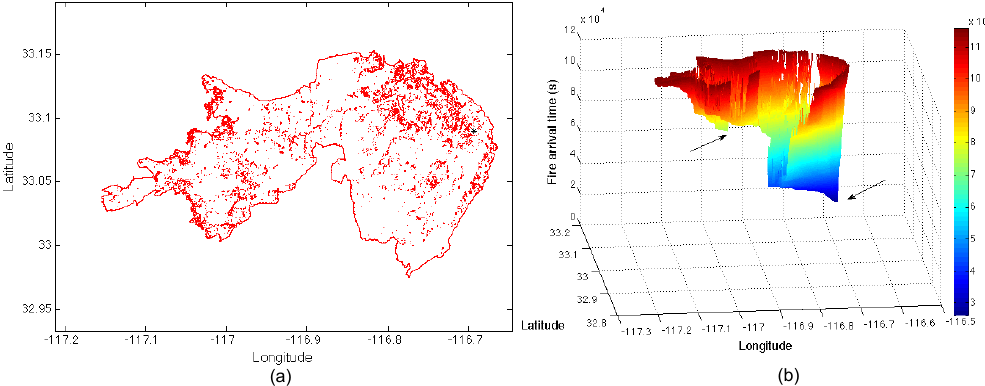
Figure 4. (a) Perimeter of the 2007 Santa Ana fires simulation 22 October 2007, 13:00PDT (Kochanski et al., 2013b). (b) Artificial-fire arrival time found by fire propagation back in time from the fire perimeter in (a) . The fire consisted of two fires, Witch and Guejito, which started on 21 October 2007, 12:15PDT and 22 October 2007, 13:00PDT, respectively, and subsequently merged. The two peaks on the bottom, marked by arrows, are the two ignition locations and times, found automatically from the perimeter. The vertical axis and the false color are the time from the beginning of the